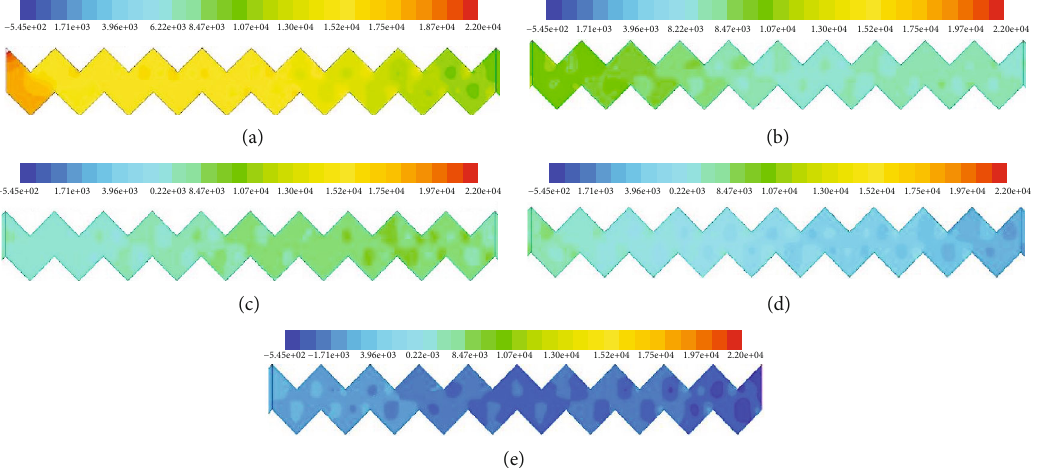
= 0 mm to X = 20mm fracture segment; (b) X 1 1 = 60mm to X = 80mm fracture segment; (e) X 1 1